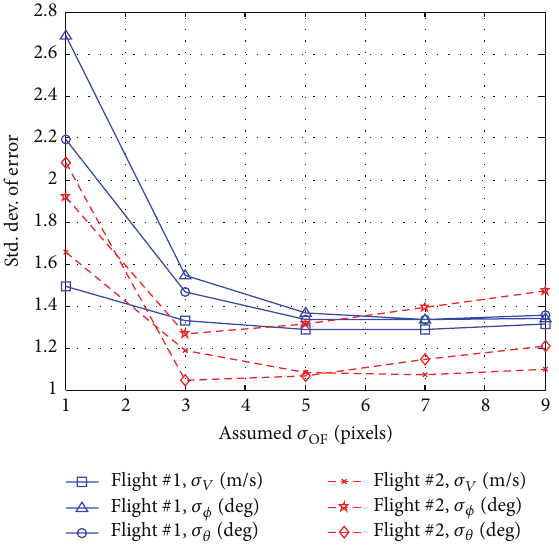
Figure 4: Comparison of errors for different assumed optical flow uncertainties.